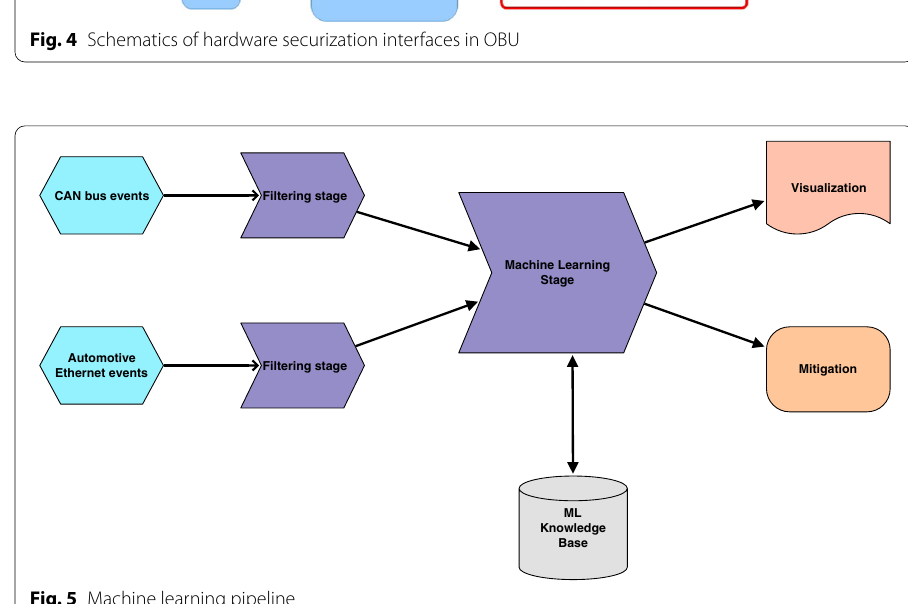
Fig. 5 Machine learning